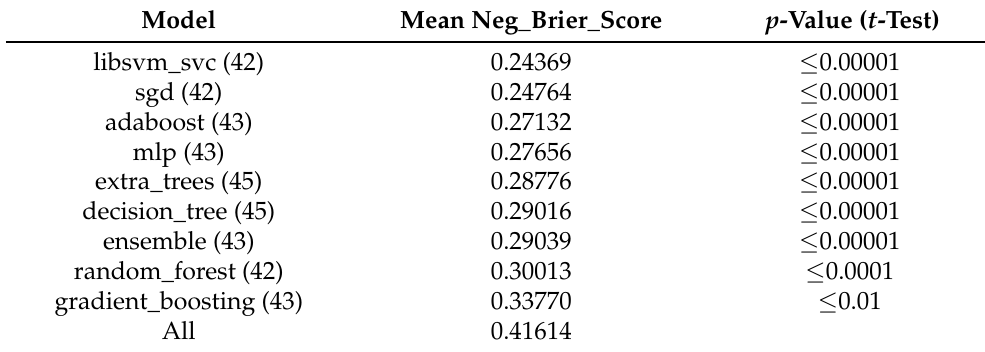
Table A14. Models with significantly better mean Brier score loss.